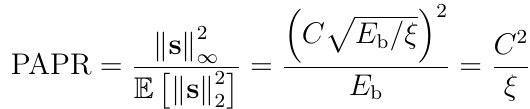
Figure 1. Histogram of the noiseless received symbols for M = 3 , E √ C = 3 E and p = 0 . 3 . The value of λ is for K = 1 . The lower part is a rescaled version b of the upper